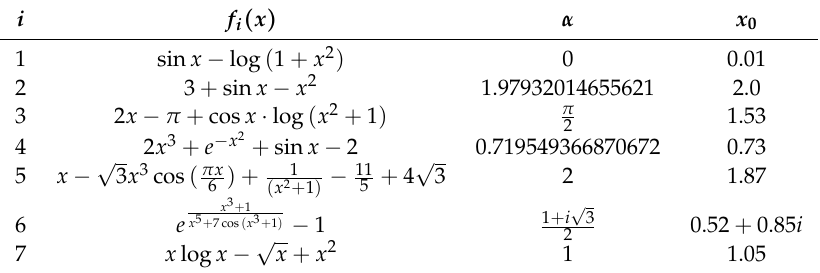
Table 1. Test functions f i ( x ) with zeros α and initial guesses x 0 .